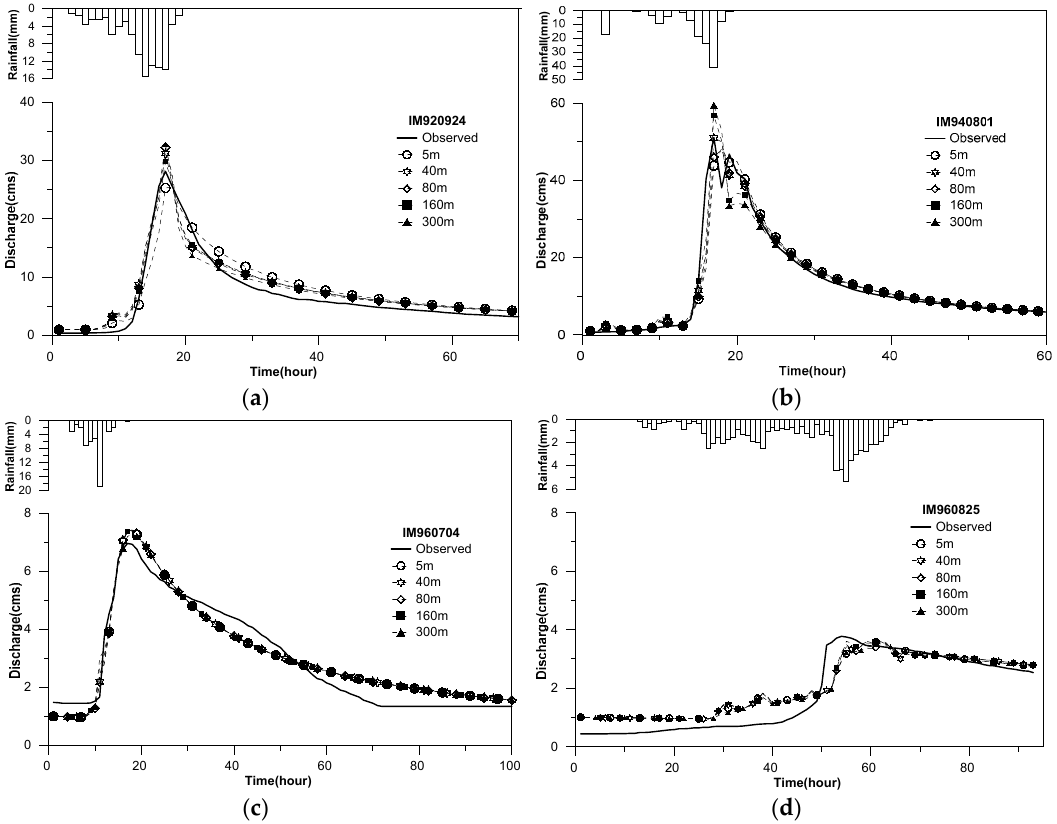
Figure 13. Rainfall–runoff events by applying optimized parameters in the Ieemokjung watershed depending on each DEM resolution. ( a ) 24 September 1992. ( b ) 1 August 1994. ( c ) 4 July 1996. ( d ) 25 August 1996.